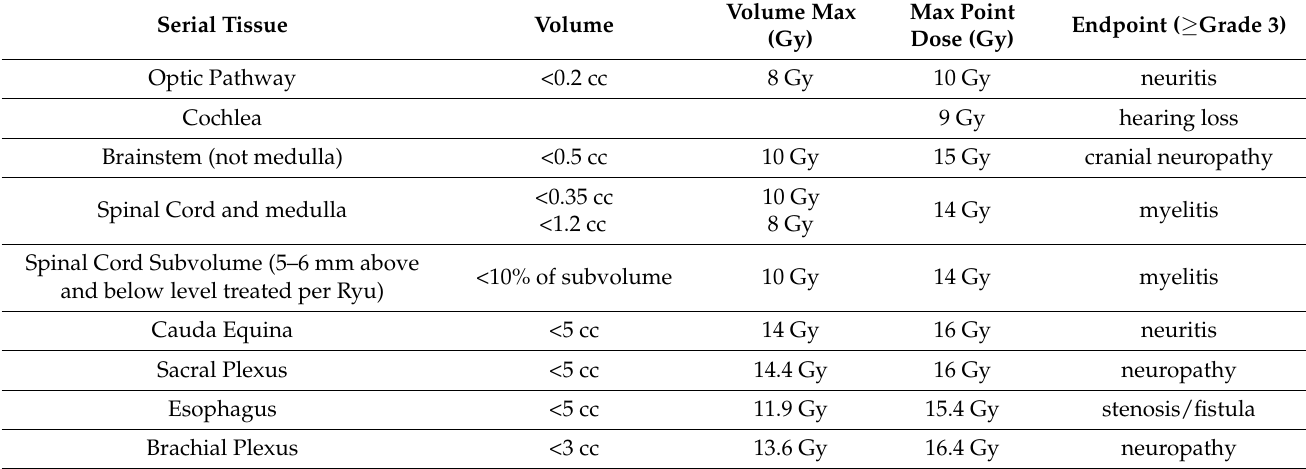
Table 1. Tolerance doses in one